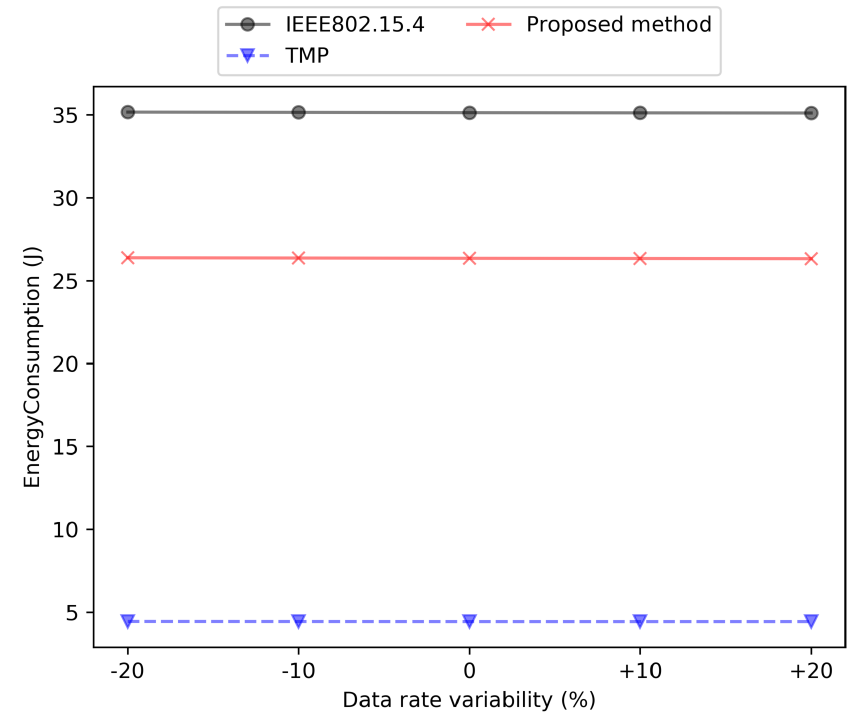
Figure 17. Sensitivity analysis of energy consumption.